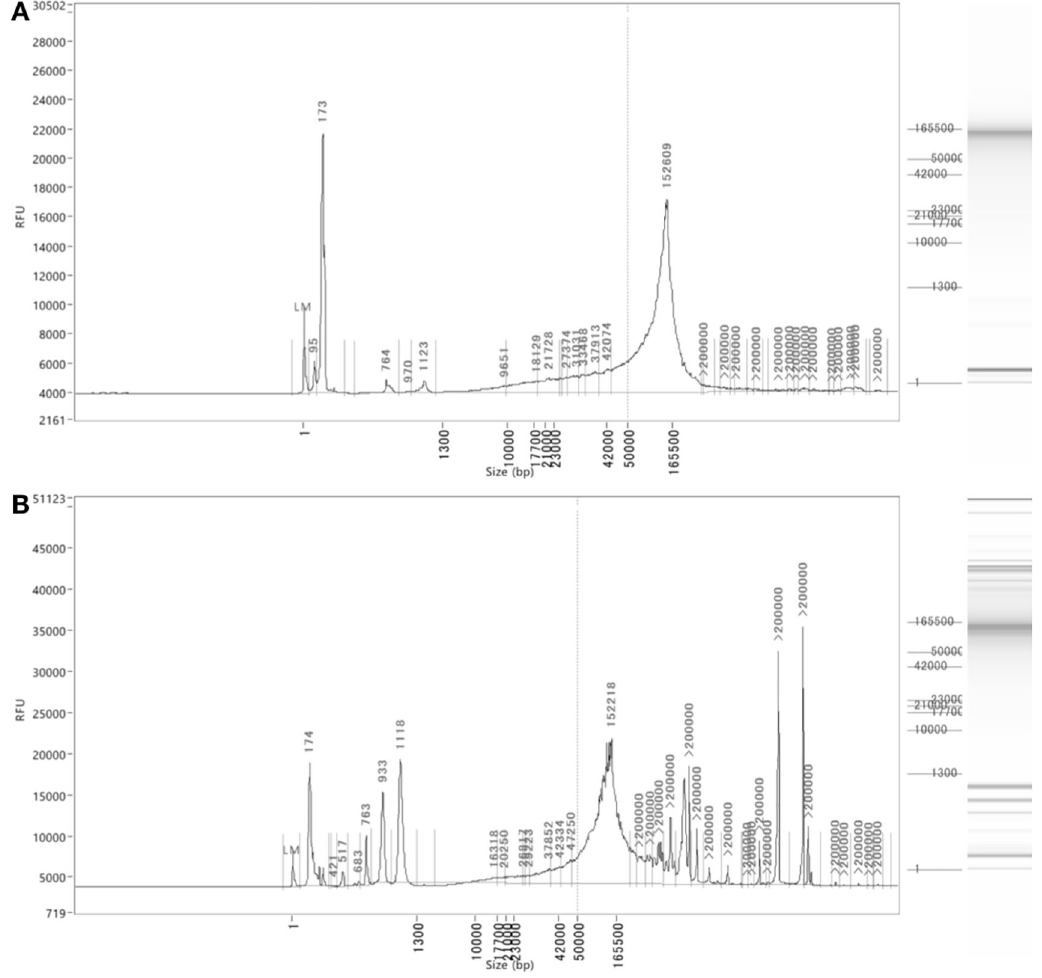
Figure 3. Representative Femto Pulse fragment length results from: A, cyanobacteria ( Synechococcus sp. ) and B, microalgae ( Rhinomonas reticulata ).